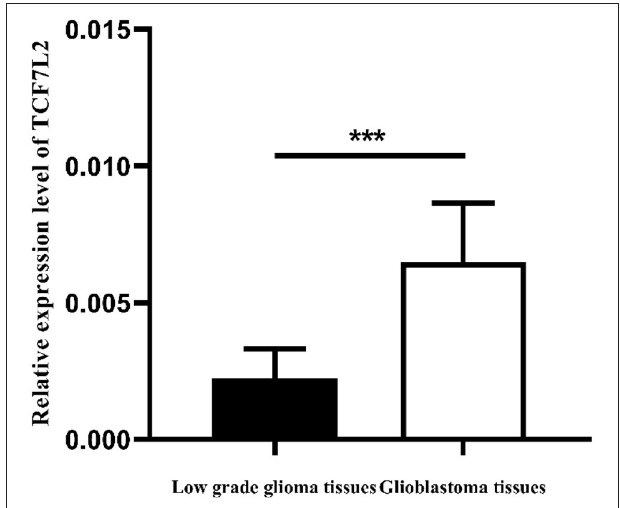
FIGURE 1 | Expression levels of TCF7L2 in GBM tissues were significantly higher (*** p = 0.001).